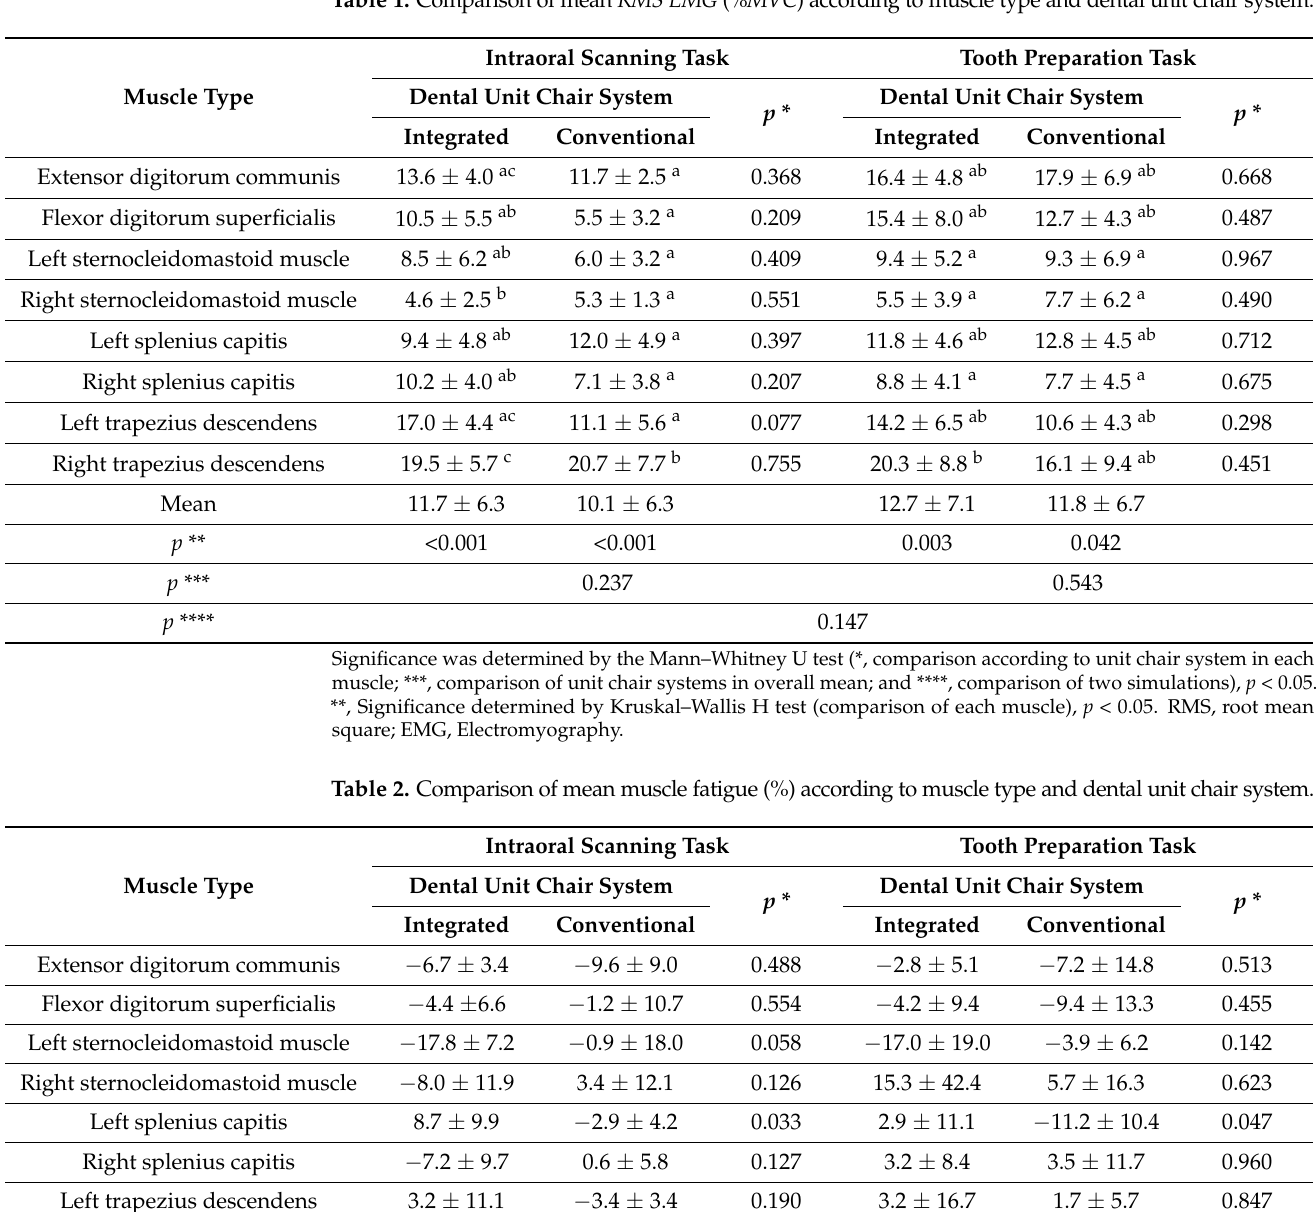
Table 1. Comparison of mean RMS EMG (% MVC ) according to muscle type and dental unit chair system.